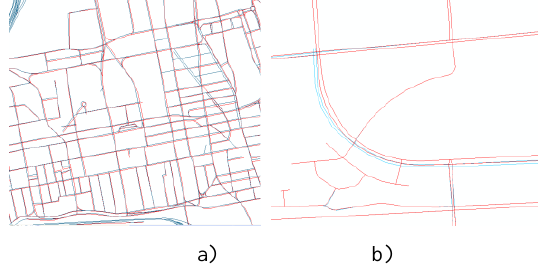
Figure 8 Difference in position of line data between two datasets: a) Durban – epoch 6-7 and b) Universitas – epoch 6-8